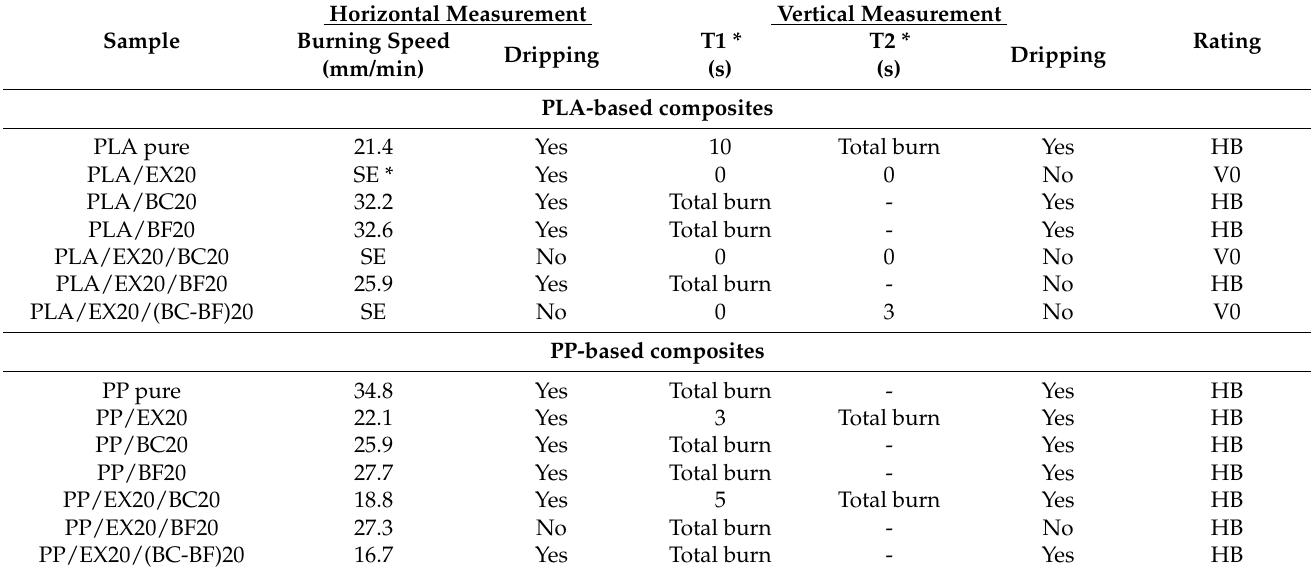
Table 3. The results of UL-94 tests performed in horizontal and vertical